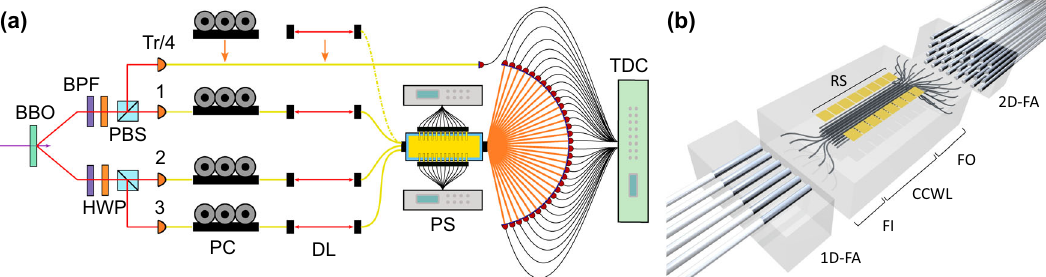
Fig. 2 Scheme of the experimental apparatus. a A parametric down-conversion process in a Beta-Barium Borate crystal generates one- and two-pair photon states. Generation in the single-pair regime is employed for the unitary reconstruction procedures, while 3- and 4-photon states are employed for experiments in the Boson Sampling framework. Photons are prepared in their polarization and temporal degrees of freedom before coupling in the input single-mode fi ber array. After evolution, photons are fi nally detected via a set of 32 single-photon avalanche photodiodes connected to a 32-channel time-to-digital converter for the reconstruction of the coincidence pattern. b Schematic of the in- and out-coupling of the single photons with the 3D photonic circuit: one- and two-dimensional fi ber arrays connect to the fan-in and fan-out sections of the circuit. Legend: BBO beta-barium borate crystal, BPF band-pass fi lter, HWP half-wave plate, PBS polarizing beamsplitter, PC polarization controller, DL delay line, PS power supply, TDC time-to-digital converter, 1D-/2D-FA one-/two-dimensional fi ber array, FI fan-in, FO fan-out, CCWL continuously-coupled waveguide lattice, RS